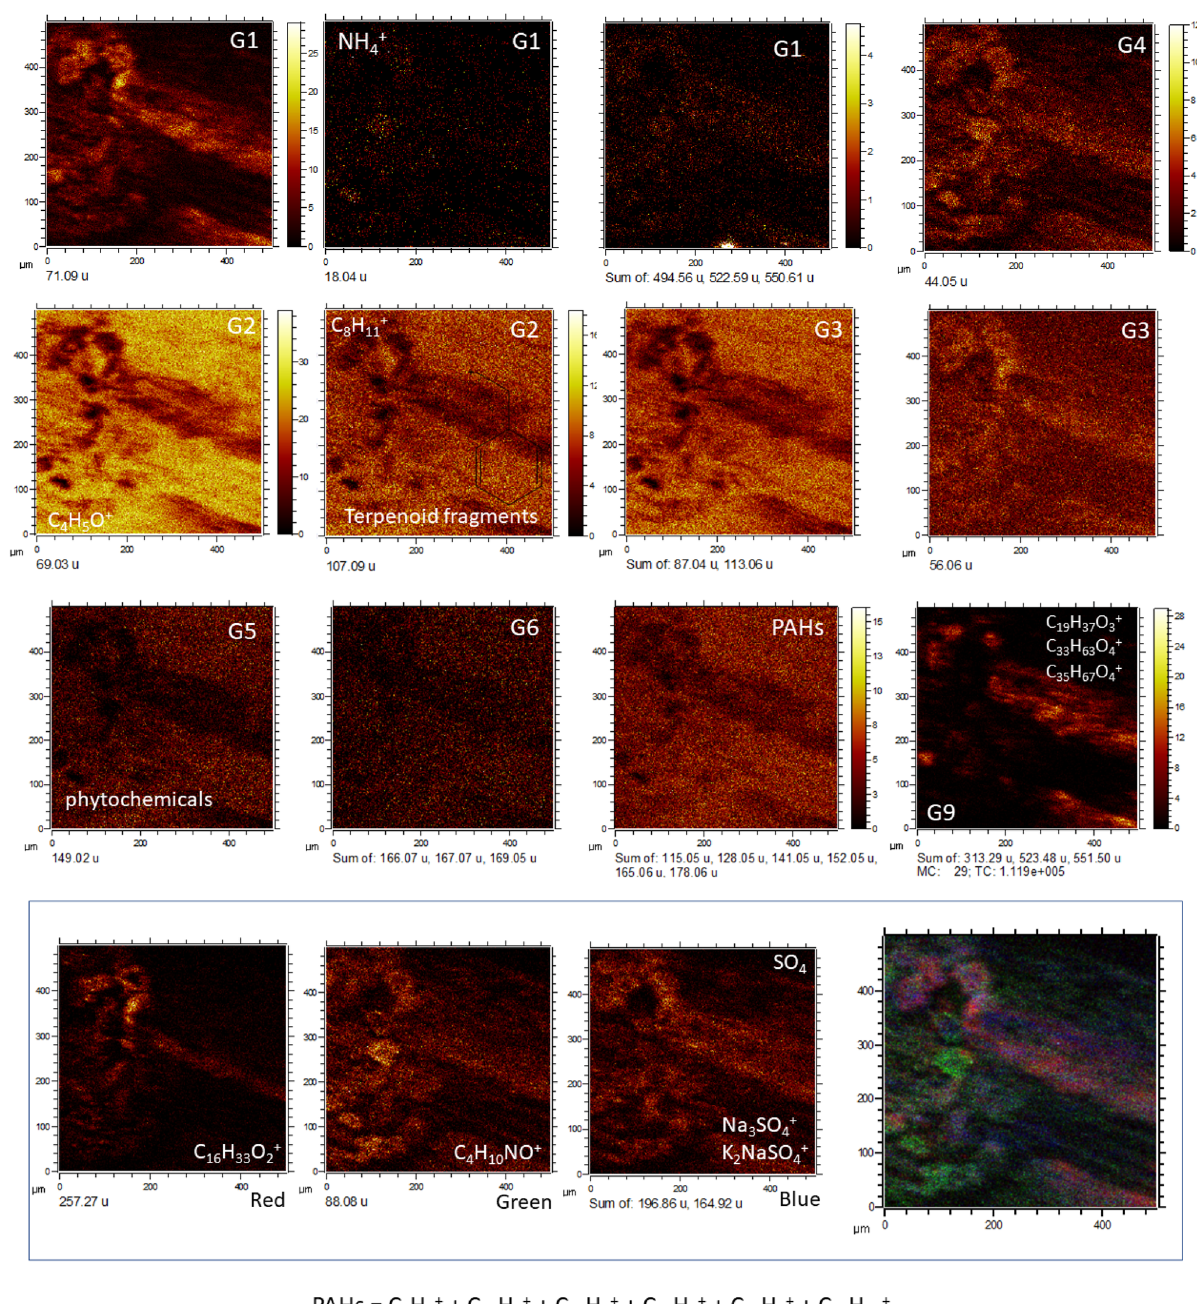
Figure 7. Identification of biological microstructures using ToF–SIMS molecular imaging in Target Area 3 (TA3). Groups G1, G3, G4, and G9 outline different oval elements (< 80 microns) that are associated with parallel straight structures longer than 500 microns. Interestingly, groups G2, G5, and G6, which have been associated with phytochemicals as well as PAHs, occur in the mineral matrix that encloses the biological structure. Such a distribution suggests that the microbial structure had been transported or was thriving in a water mass that was enriched in refractory organic compounds such as PAHs and some phytochemicals. The RGB overlay shows that the biological structure has compositional changes that represent sulfate biomineralization (Na 3 SO 4+ , and K 2 NaSO 4+ ), as well as sphingolipid (C 4 H 10 NO + ) and acylglyceride fragments (C 16 H 33 O 2+ ). The PAH intensity image was obtained by adding the intensities of different PAHs such as C 9 H 7+ ,